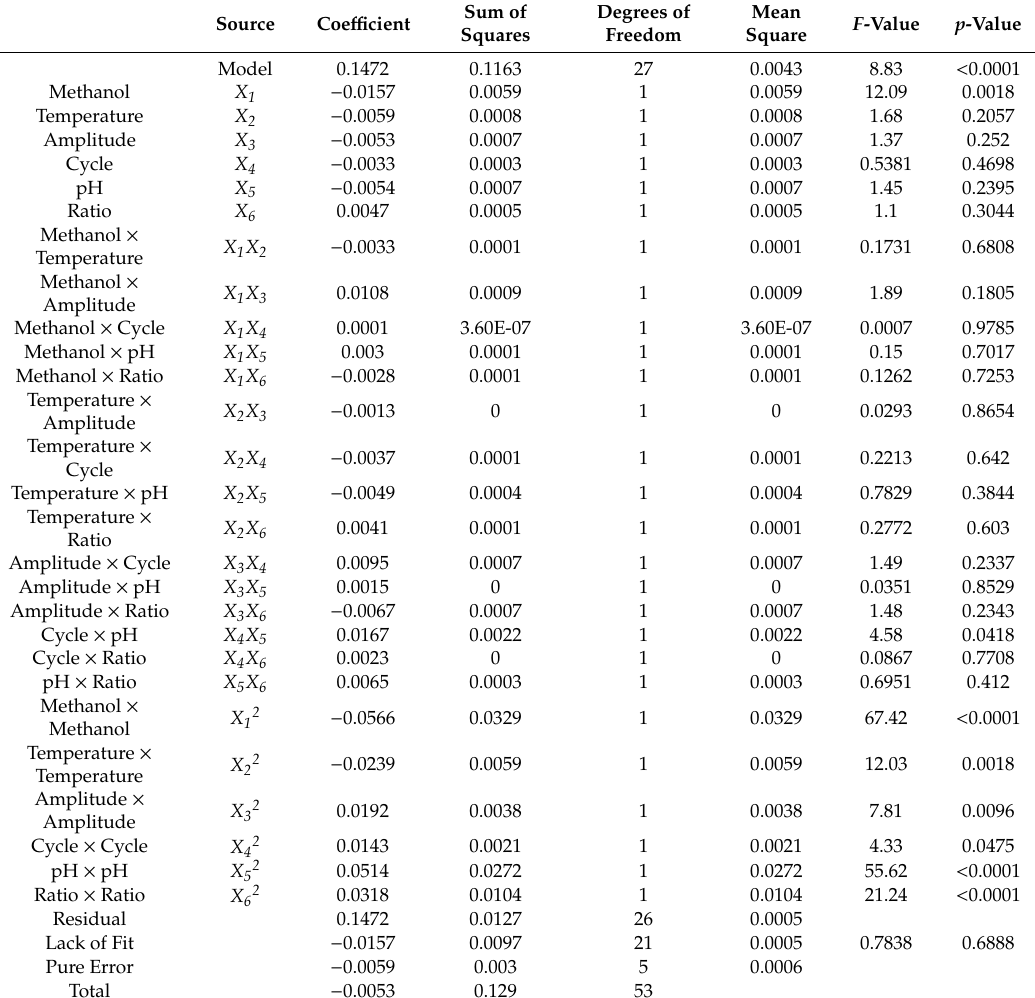
Table 3. ANOVA for the response surface quadratic model for total